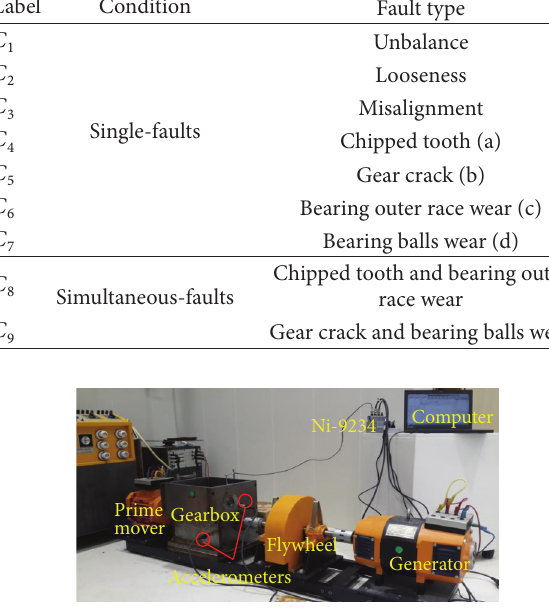
Figure 5: Fault simulator for gas turbine generator